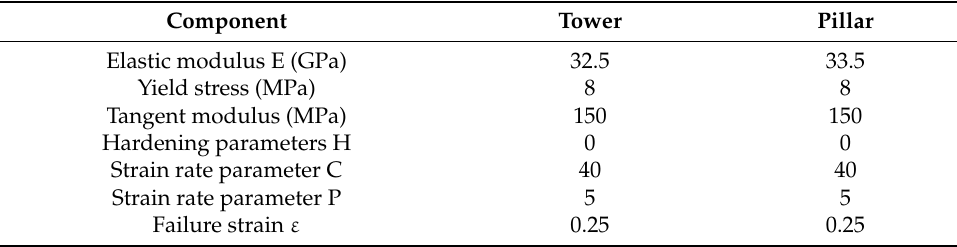
Table 3. List of material model parameters.